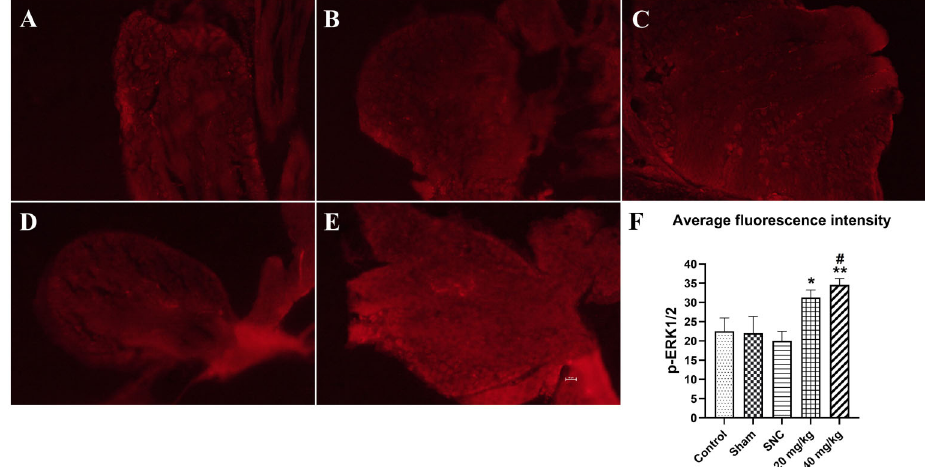
Figure 3. Effects of pinostrobin (PB) treatment (20 and 40 mg/kg) on p-ERK1/2 average fl uorescence intensity in dorsal root ganglion (DRG) after sciatic nerve crush (SNC) at 28 days. ( A ) Control, ( B ) Sham, ( C ) SNC, ( D ) 20 mg/kg PB, and ( E ) 40 mg/kg PB (scale bar=50 m m). F , Quantitative analysis of p-ERK1/2 average fl uorescence intensity in DRG on day 28 after SNC. Data are reported as means ± SE (n=6). *P o 0.05, **P o 0.01 vs SNC group and # P o 0.05 vs control group (ANOVA). p-ERK1/2: phosphorylated extracellular signal-regulated kinase1/2.